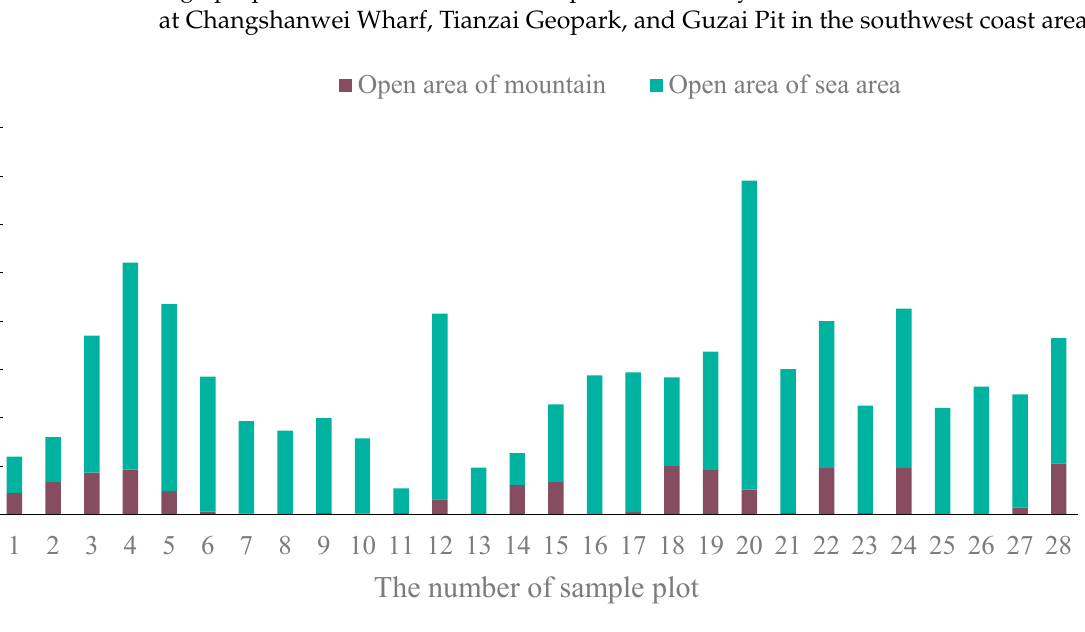
Figure 2. Distribution of open area in the sight area of the sample plot.